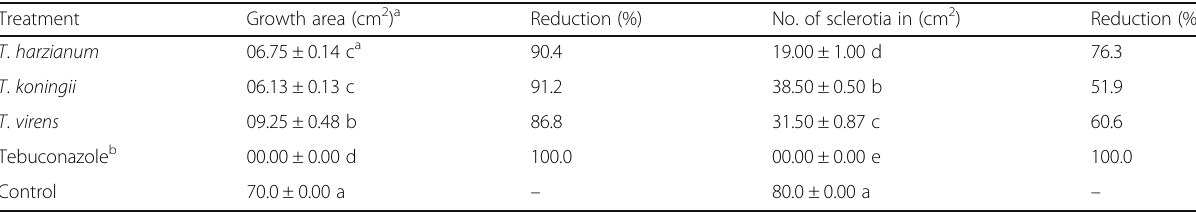
Values are mean of four replicates for each treatment as well as the control Means±standard error within a column followed by the same letter are not significantly different by Duncan multiple range test at P <0.05 a Growth area (cm 2 ) of S . cepivora was calculated using a planimeter b The fungicide tebuconazole was used at the recommended dose of 1 ml